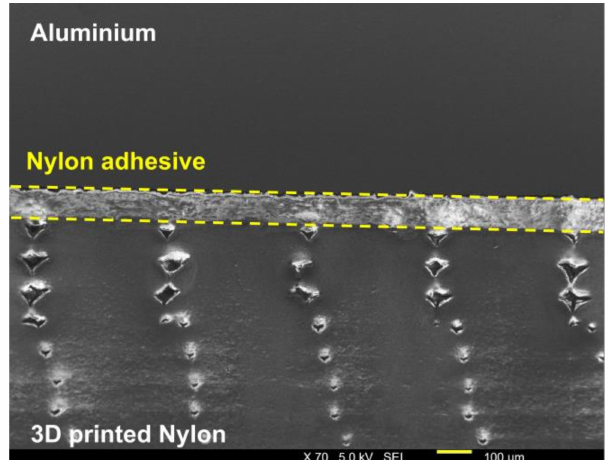
Figure 5. SEM image of a cross section of a single-lap aluminium-PA + CF joint.